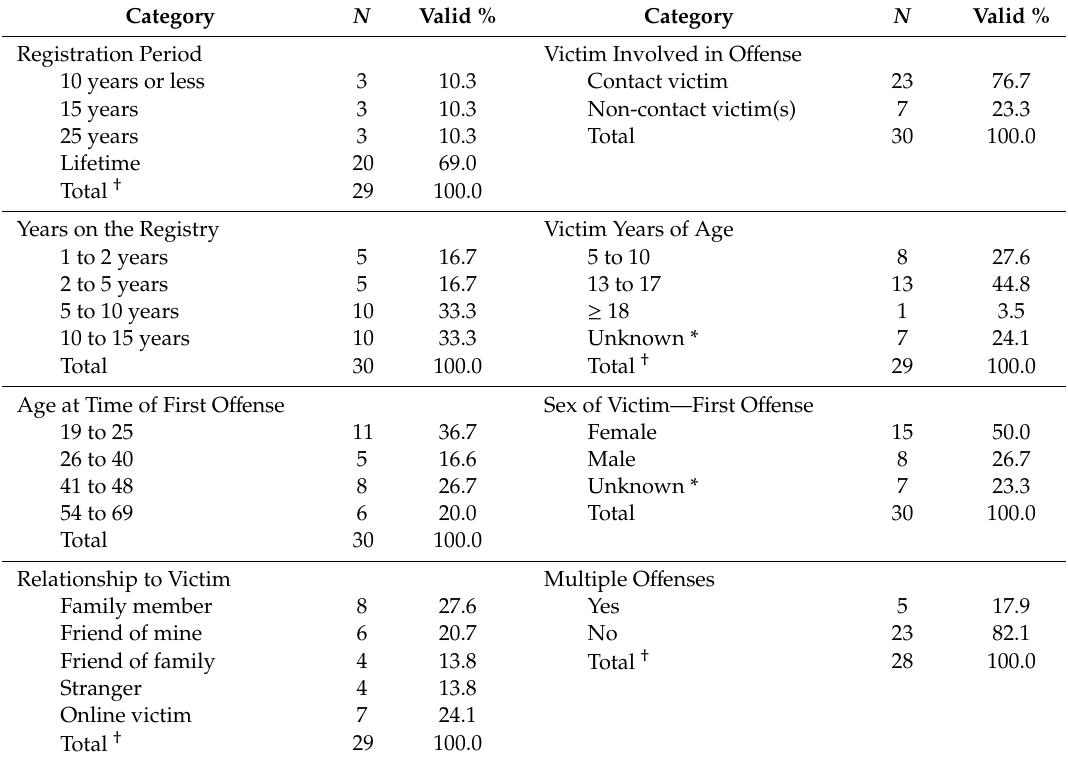
Table 2. Participant registration, sexual o ff ense, and victim